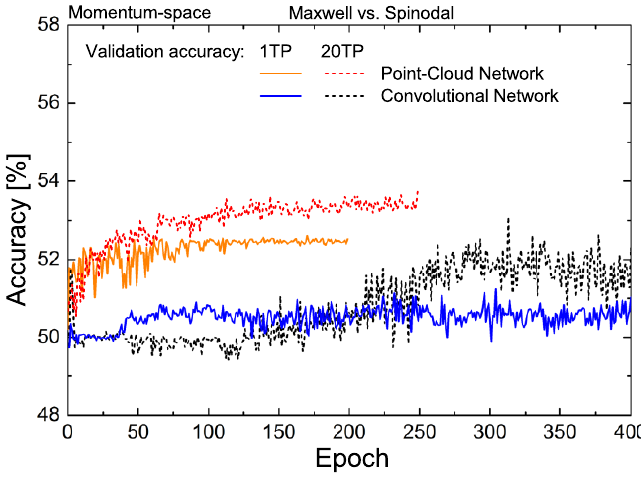
Figure 4 . Validation accuracy for the CNN and the PCN, comparing the spinodal EoS and the Maxwell construction for TP=1 and TP=20 . The PCN shows a better performance than the CNN, but both network structures display only a very low validation accuracy just above